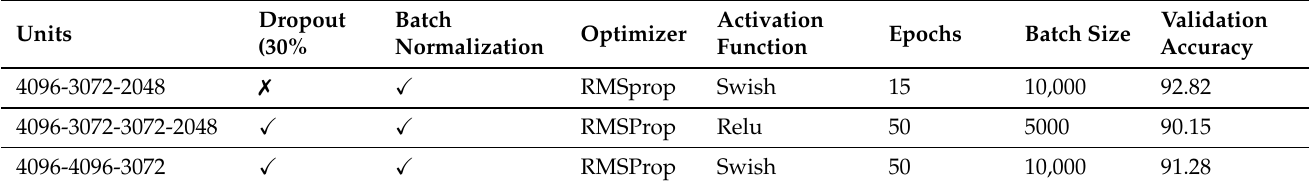
Table 4. Comparison of a few models which were used for the blood pressure